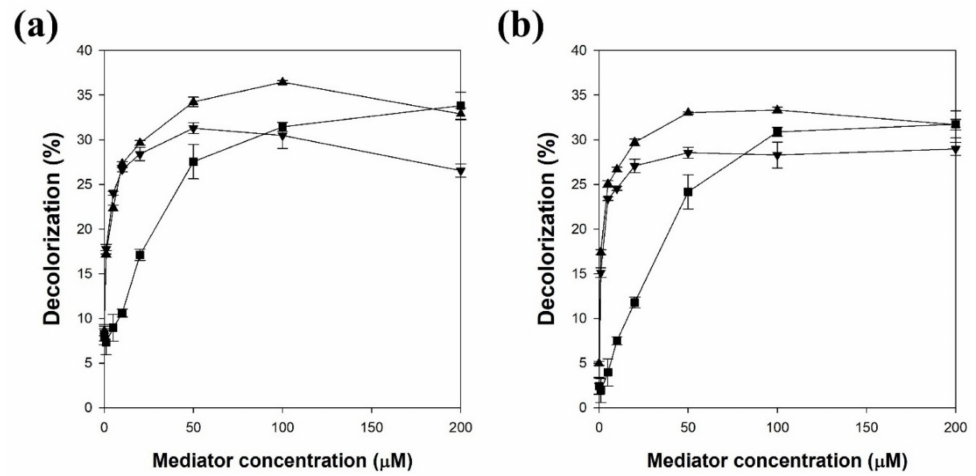
Figure 3. The effect of mediator concentration on the melanin decolorization by LMS using laccase from T. versicolor ( a ) and M. thermophila ( b ). (cid:78) : acetosyringone, (cid:72) : syringaldehyde, (cid:4) : acetovanillone. Reaction conditions: 50 µ g/mL melanin and 0.1 M citric acid phosphate buffer (pH 5.5) at 25 ◦ C for 24 h.